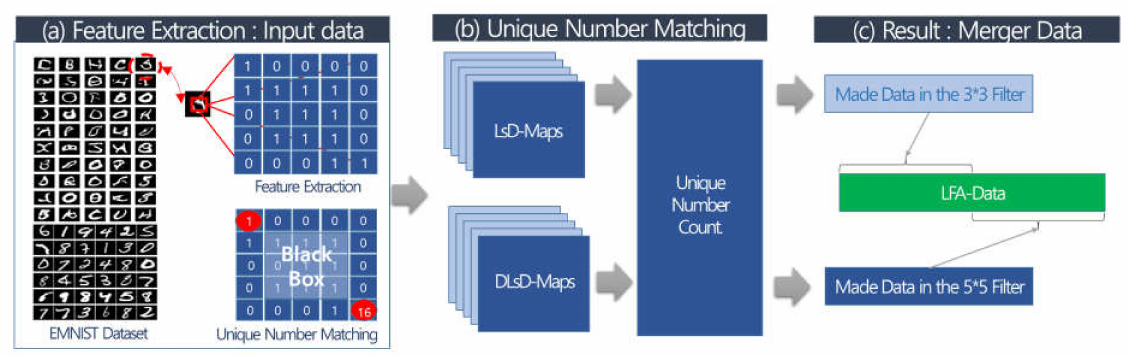
Figure 8. Eigenvalue aggregation of the line-segment feature